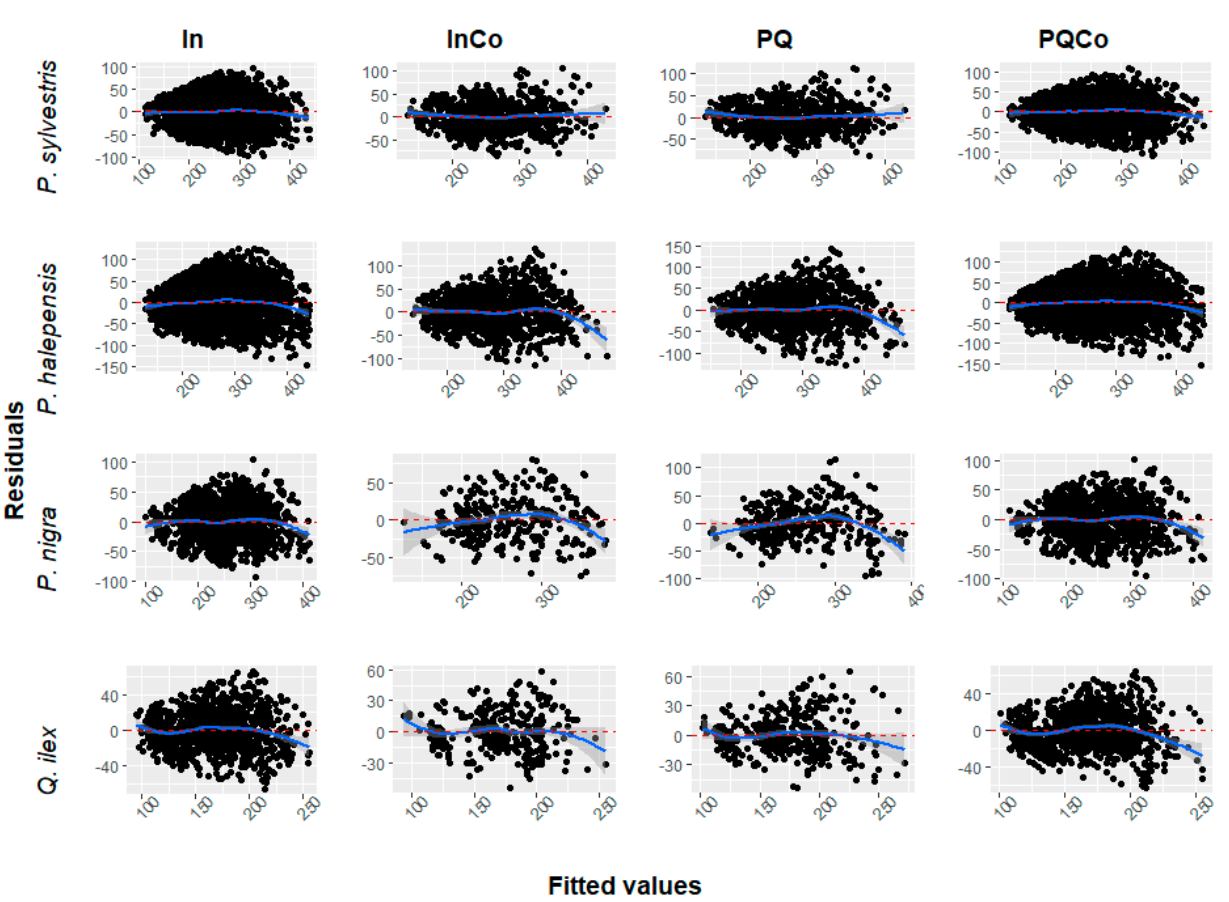
Figure A5. Diagnostic plot (residual vs. fitted values) of the linear model for observed vs. predicted DBH4 with the closest neighbor, plot for each method and species. Table A2. Confidence interval at the 95% level for the intercept and for the slope of the linear model between the observed DBH4 and the predicted DBH4 for untracked trees considering two aggregation levels (individual (In) and plot-quantile classes (PQ)), and Equations (1) and (2) (Co for competition).